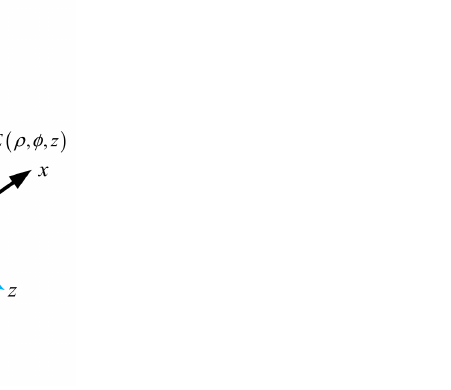
Figure 1. Schematic diagram of cylindrical vector beams through a lens with high numerical